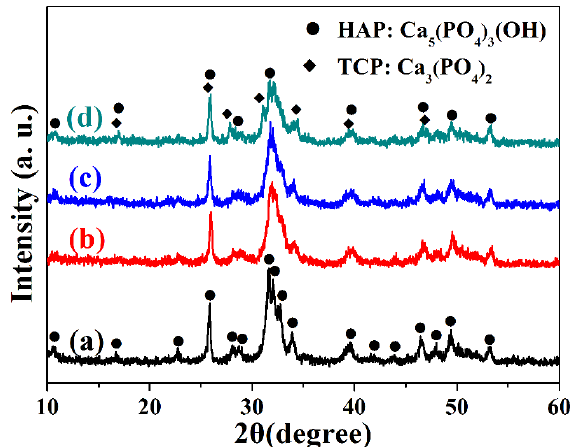
Figure 2. XRD patterns of calcium phosphate nanostructures prepared by microwave-assisted hydrothermal method under different pH values: ( a ) Sample A, pH = 5; ( b ) Sample B, pH = 7; ( c ) Sample C, pH = 9; ( d ) Sample D, pH = 11.